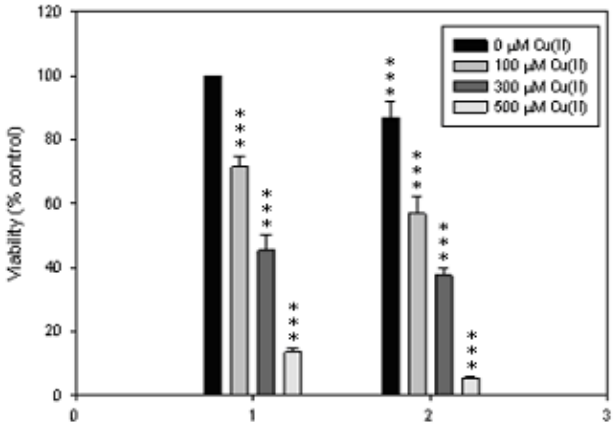
Figure 6. Copper-dependent increases in KQ -mediated cytotoxicity. SCM-1 cells were exposed to 0 (1) and 50 μ M (2) KQ , respectively, and varying concentration of Cu(II) for 48 h and cell viability was measured by MTT assay. *** p < 0.001 represents significant differences compared with control